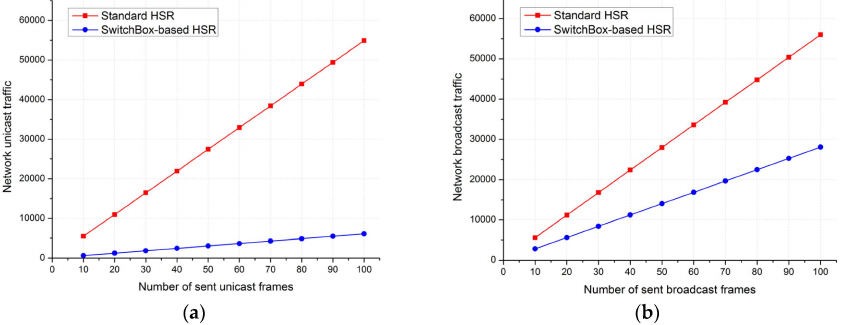
Figure 29. Comparison of the network traffic performance between the standard HSR and the SwitchBox-based HSR in case 2 of Simulation 3. ( a ) Unicast traffic; ( b ) Broadcast